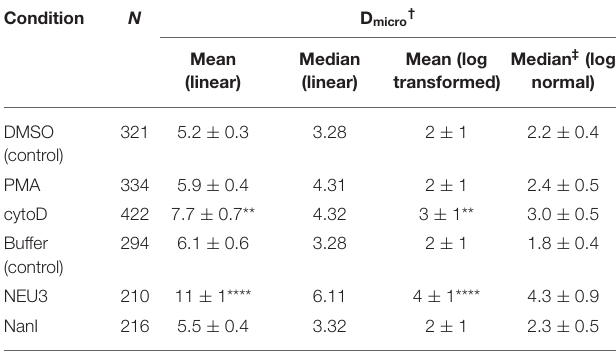
TABLE 1 | Diffusion of LFA-1 determined using